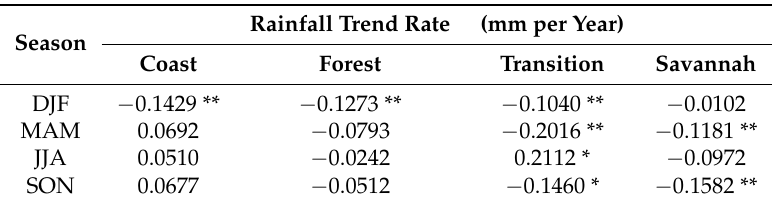
Table 1. Seasonal rainfall trend rate in the four agro-ecological zones (** and * indicates significant trends at 0.01 and 0.05 significance levels respectively). Rainfall Trend Rate (mm per Year) Season Coast Forest Transition Savannah DJF − 0.1429 ** − 0.1273 ** − 0.1040 ** − 0.0102 MAM 0.0692 − 0.0793 − 0.2016 ** − 0.1181 ** JJA 0.0510 − 0.0242 0.2112 * − 0.0972 SON 0.0677 − 0.0512 − 0.1460 * − 0.1582